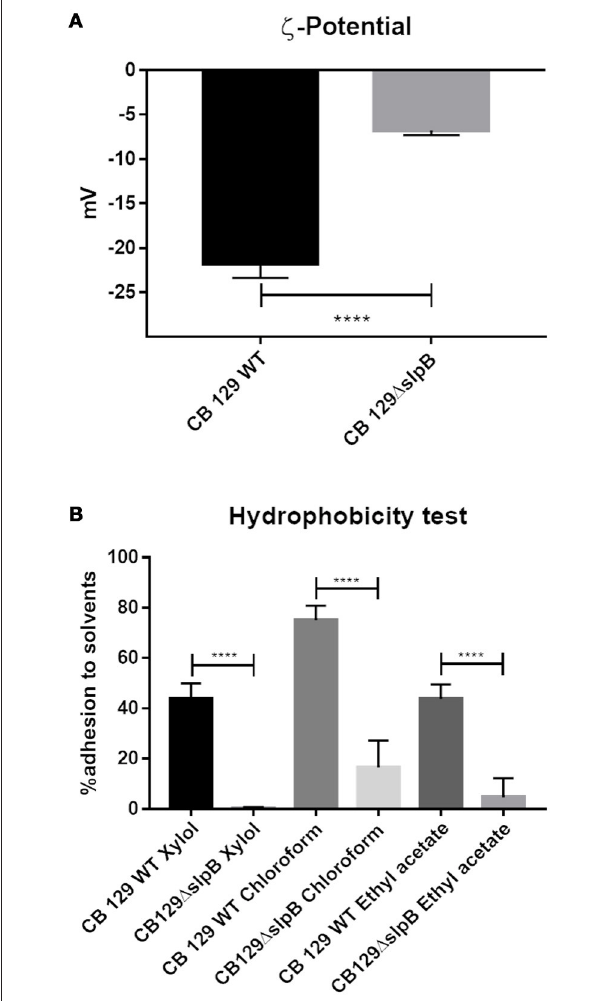
FIGURE 1 | Mutation of slp B gene drastically affects surface proprieties in P. freudenreichii CIRM-BIA 129. (A) The surface net charge was determined by measuring the ζ -potential. (B) The surface hydrophobicity was determined by quantifying adhesion to solvents (Xylol, Chloroform, and Ethyl Acetate). Wild-type (WT) and mutant CB129 1 slpB strains were compared. Bar represents the mean SD of three biological replicates and three technical replicates. The asterisks (****) denotes the statistical significance of the represented value between CB 129 WT and CB 129 1 slpB ( p > 0.0001).